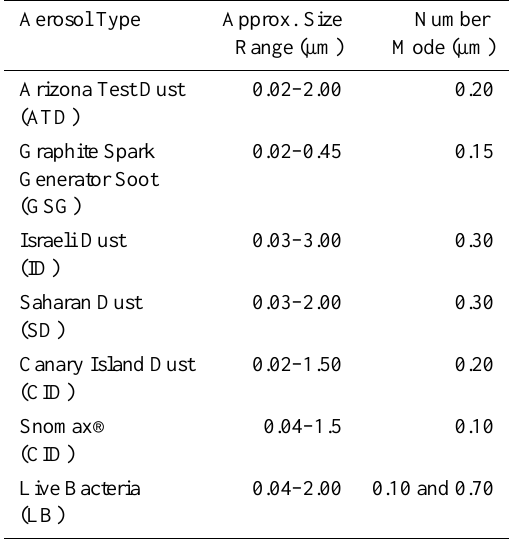
Table 1. Size distributions of aerosol samples in APC